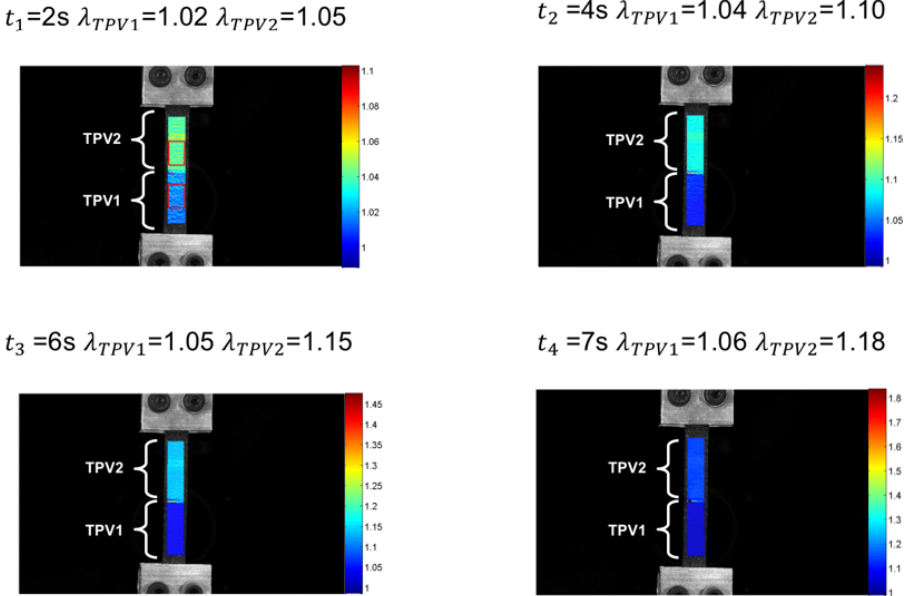
Figure 11. Stretch evolution for each TPV overmoulded at 190 ◦ C, in the case of monotonic tensile test until